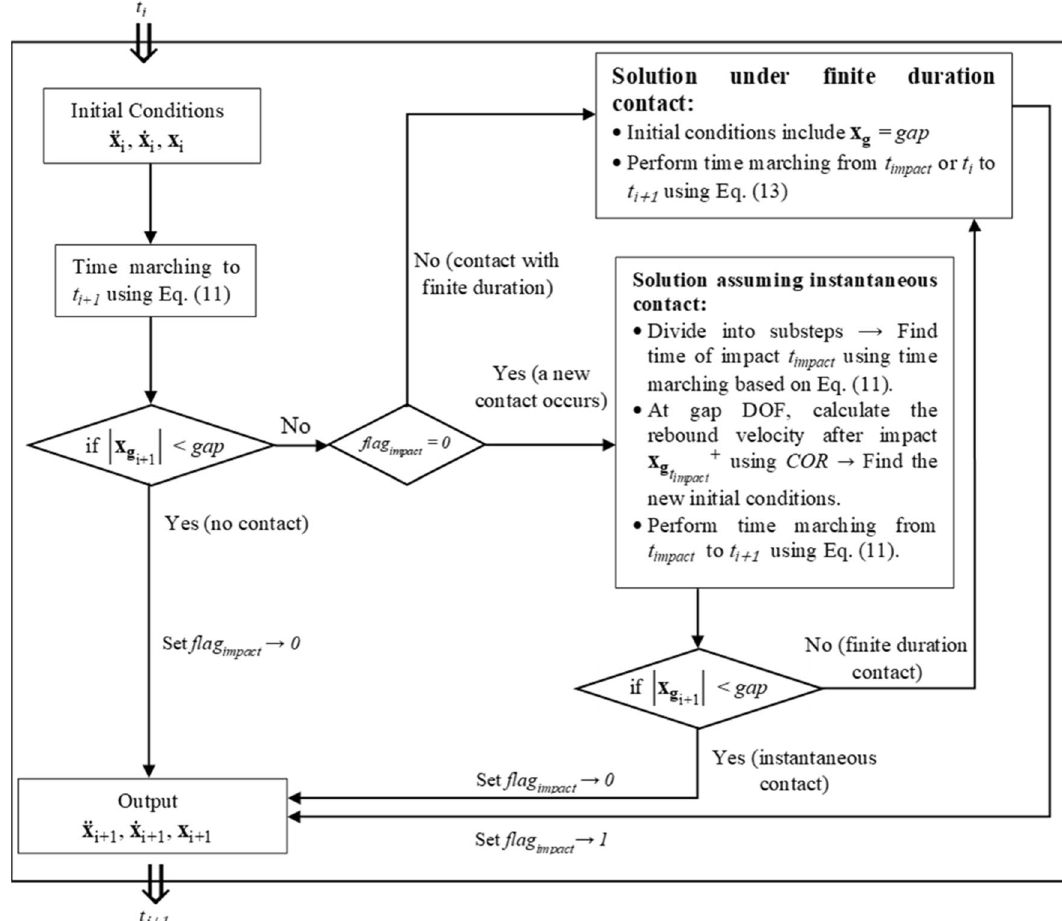
Figure 4. Flow chart for the implementation of the impact in the transient analyses in